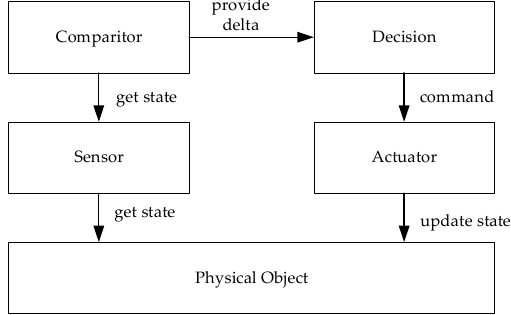
Figure 5. Conceptual model for a control system as derived from the literature.